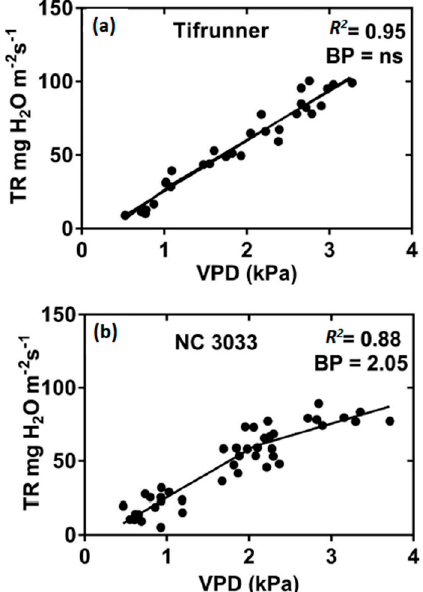
Figure 2. Plot of transpiration rate (TR) vs. vapor pressure deficit (VPD) of 5 week old plants of ( a ) Tifrunner and ( b ) NC 3033 [37]. Entire plants were enclosed in individual mini-chambers (21 L) and TR was measured gravimetric for 1-exposure at each VPD. Regression analysis showed a linear increase in TR for Tifrunner over the entire range of tested VPD while a two-segment response was found for NC 3033 with a breakpoint (BP) between segments at 2.05 kPa.